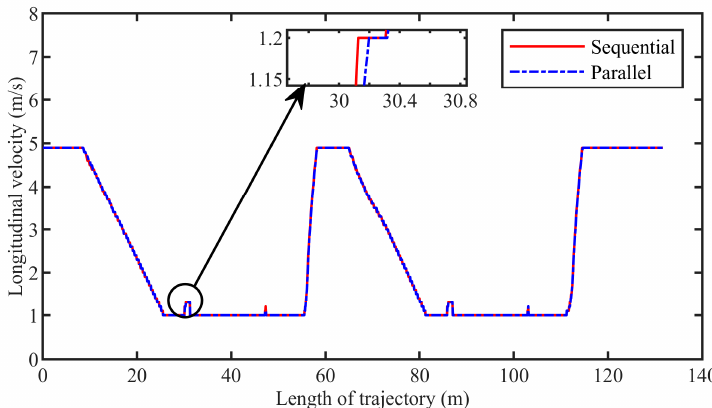
Figure 12. The longitudinal velocity of the comparison between calculation processes.